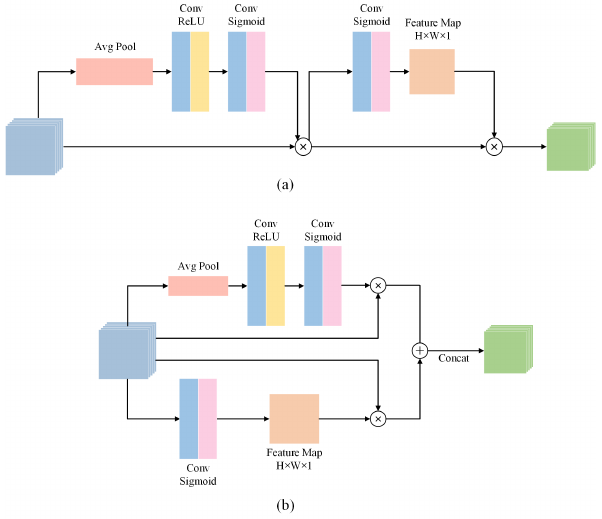
Figure 6. Two forms of feature remapping module. ( a ) Cascaded feature remapping module (C-FRM). ( b ) Parallel feature remapping module (P-FRM).